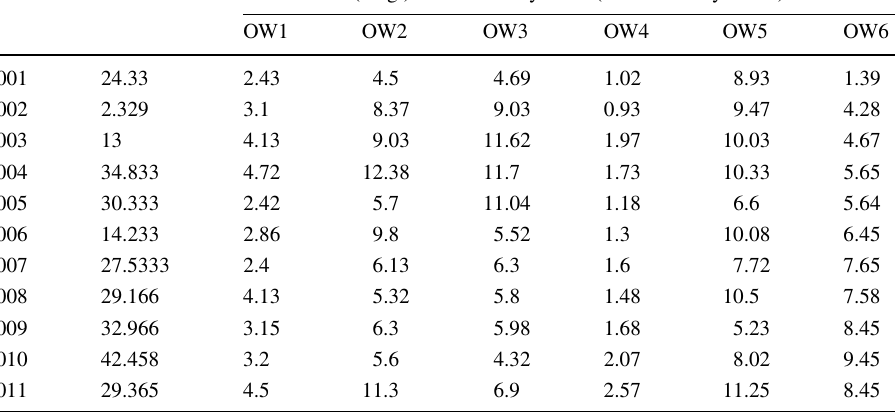
Table 7 Post-monsoon rainfall and water-table